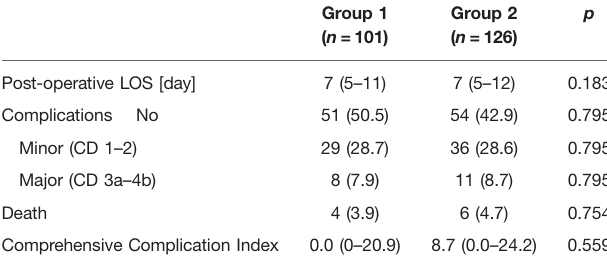
TABLE 5 | Post-operative course and complication.